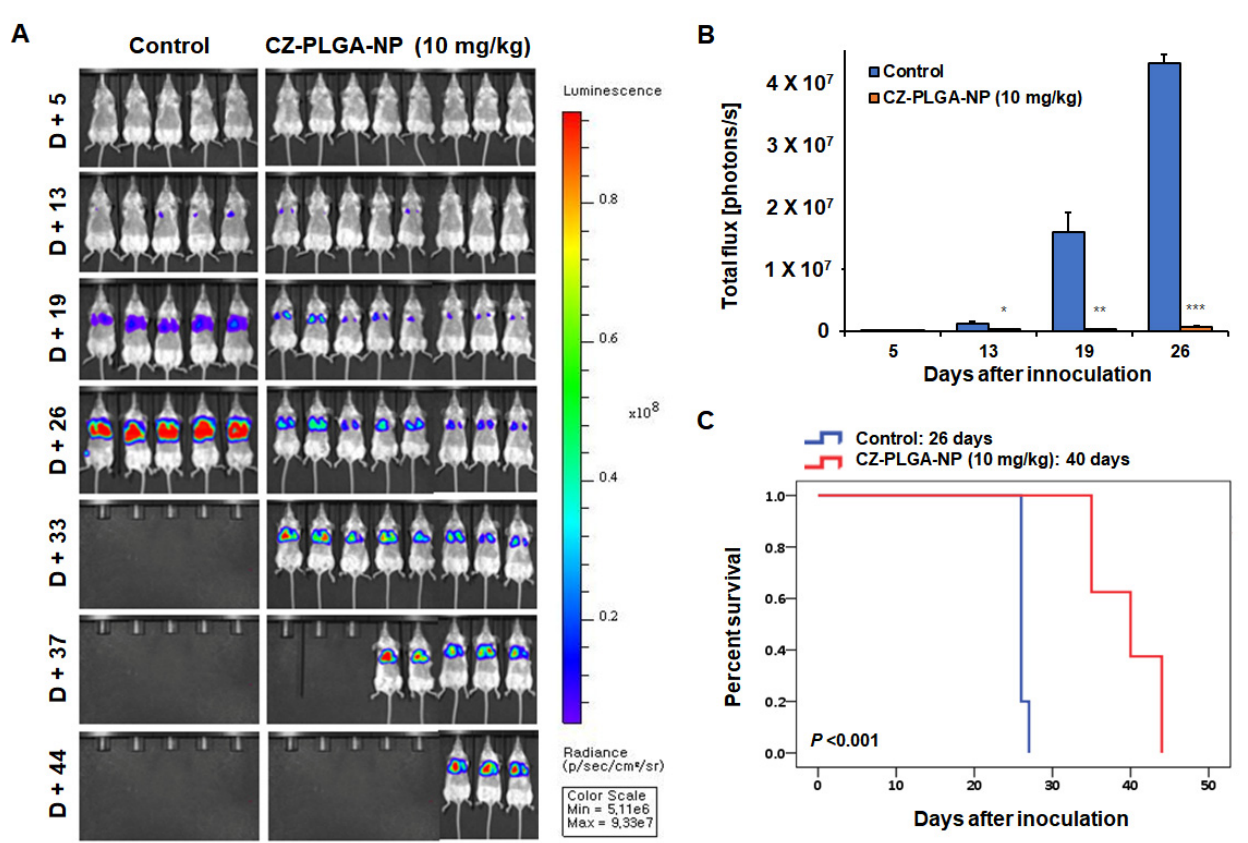
Figure 7. In vivo anti-tumor activity of CZ-PLGA-NPs against Renca-SRLu5-Luc RCC lung metastasis. ( A ) Longitudinal images of the quantification of the metastatic lung tumor growth (lung metastatic burden) based on the whole-body bioluminescence signal, measured as photons/sec. (B) The photon flux levels in the different groups of mice were measured using the in vivo imaging system (IVIS). All groups, n ≥ 5; data are presented as the mean ± standard error of the mean; * p < 0.05; ** p < 0.01; *** p < 0.001; treated vs. control groups. ( C ) Kaplan–Meier survival curve and comparison of median survival between control (no treatment, n = 5) and treatment groups (in vivo administration of CZ-PLGA-NPs 10mg/kg, twice a week, a total of eight injections during the study, n = 8) (log-rank test).